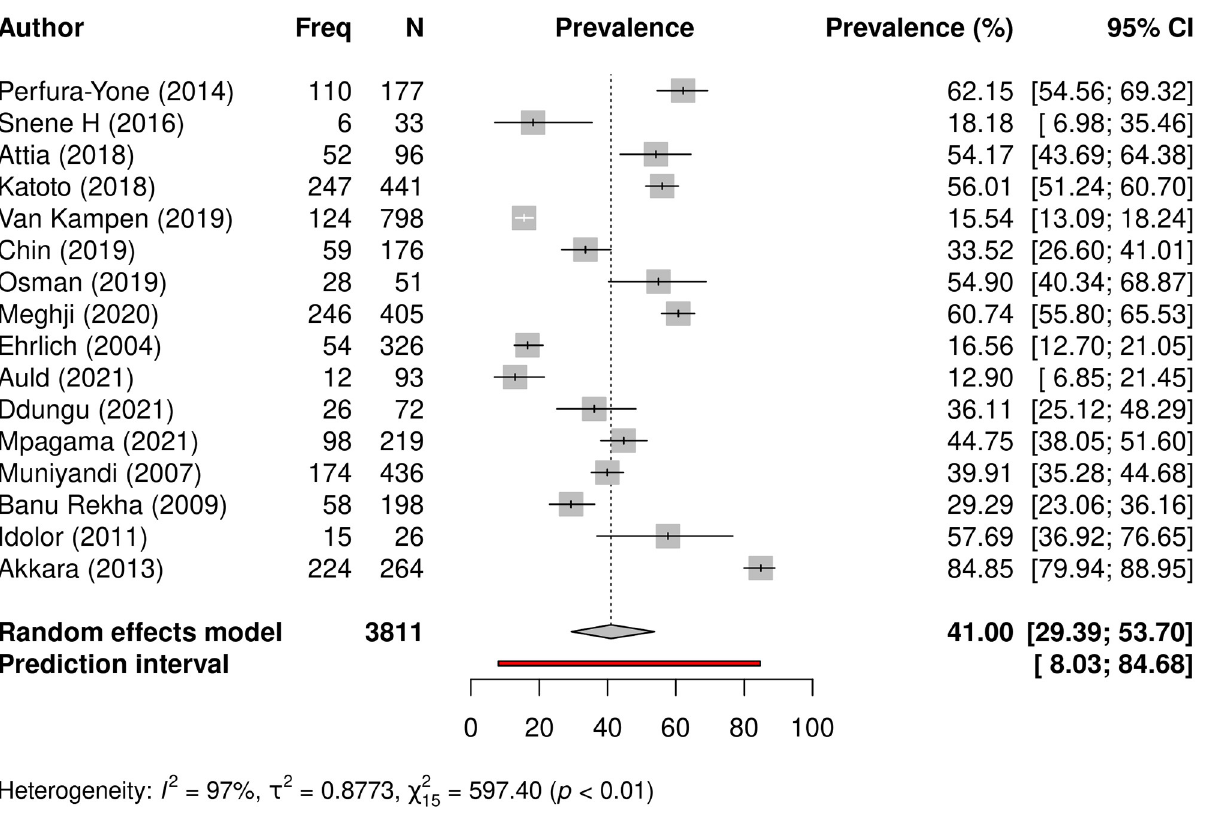
Fig 3. Prevalence of persistent respiratory symptoms following TB. A forest plot showing individual study prevalence and pooled prevalence of persisting respiratory symptoms in 16 studies that evaluated a pooled sample size of 3811 study participants for residual symptoms post-TB.